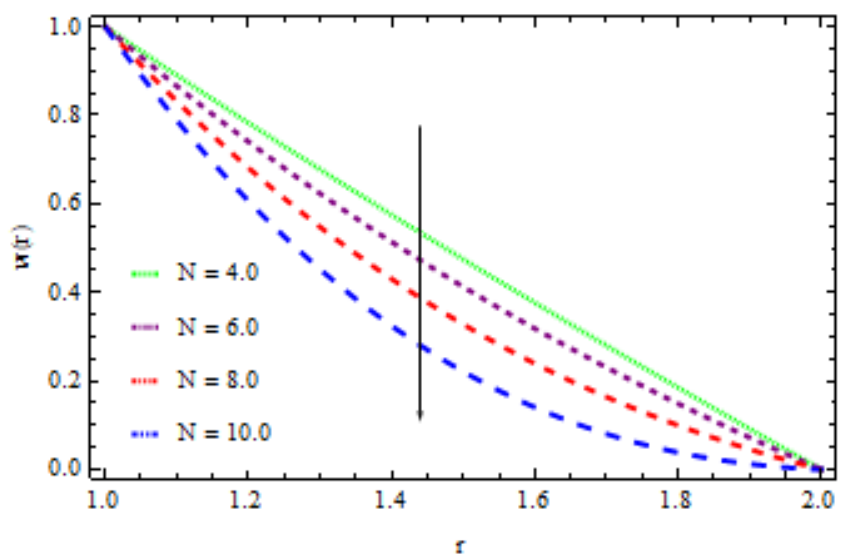
Figure 4. The influence of N on velocity distribution in the case of Reynold’s model (RM) when Q = 0.3, B r = 0.1, M = 0.5, ε = 0.8, m = 0.13, β 0 = 1.2, K p = 0.2.